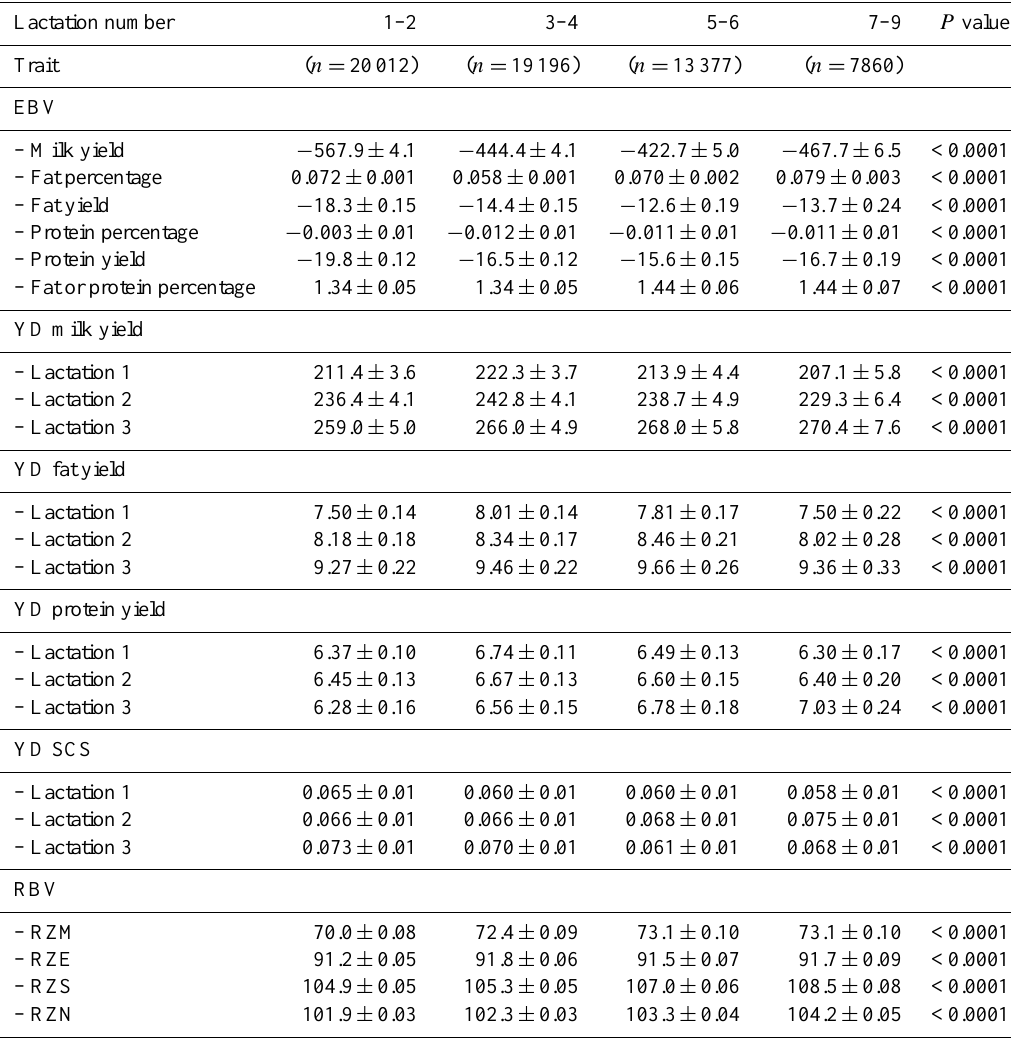
Table 3. Least-square means and standard deviations of the traits analyzed including daughter yield deviations (YDs), estimated breeding values and relative breeding values (RBVs) of contemporary herdmates (HGF) by completed lactations for milk performance (RZM), somatic cell count (RZS), type (RZE), and functional longevity (RZN) as well as P values for trait differences among EX and HGF.